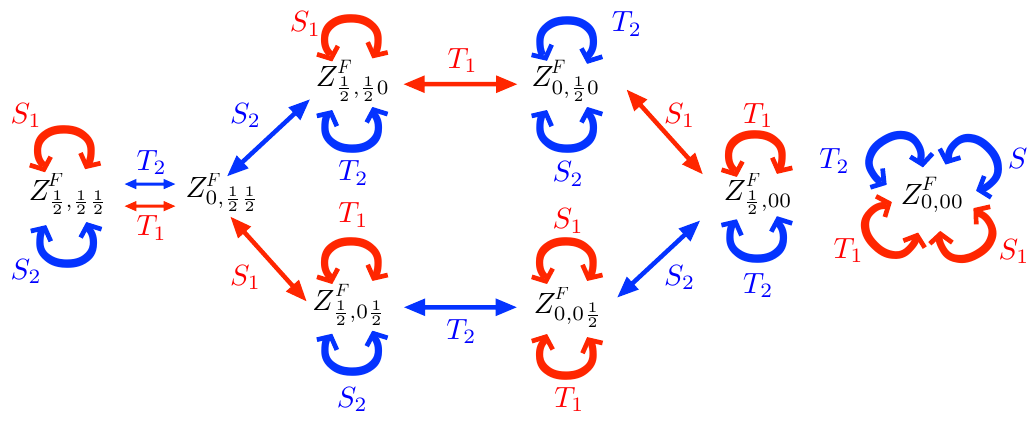
F (cid:11) 0 ;(cid:11) 1 (cid:11) 2